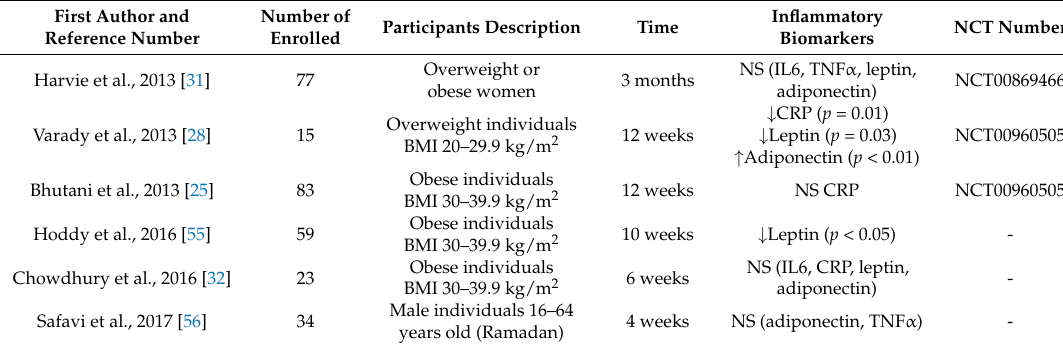
Table 3. Impact of intermittent fasting on inflammatory markers’